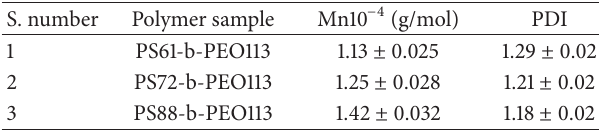
Table 1: Molecular weight and degree of dispersity of the samples of the copolymers.